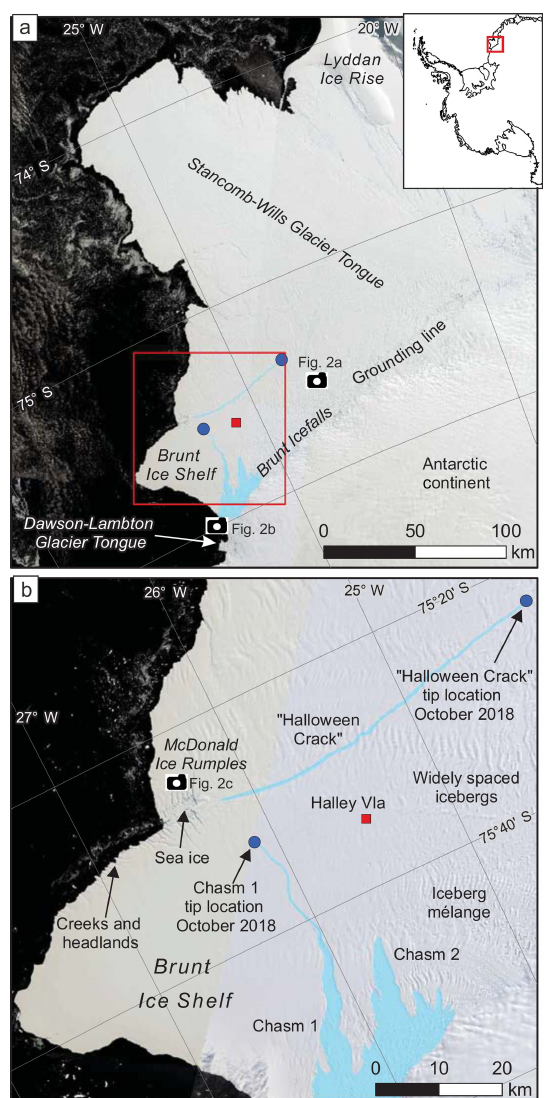
Figure 1. Study location map over Landsat 8 satellite images. (a) Composite of visible-band Landsat 8 satellite images show- ing the Brunt Ice Shelf and Stancomb-Wills Glacier Tongue. Pale blue shading highlights the current cracks and chasms seen on the ice shelf. Camera symbols approximately locate photographs in Fig. 2a–c. The red box locates panel (b) and the inset shows the study area (red) in its Antarctic context. (b) Details of the Brunt Ice Shelf showing the Halloween Crack and Chasm 1. Landsat 8 images from 5, 9, and 12 February 2018 courtesy of the U.S. Geo- logical